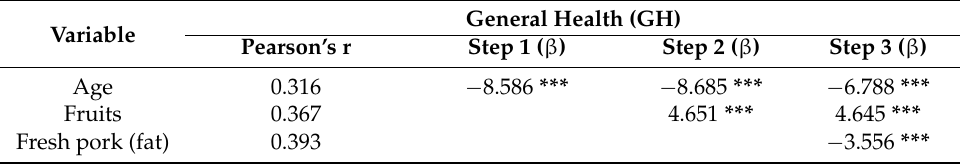
Table 7. Stepwise regression predicting the PCS